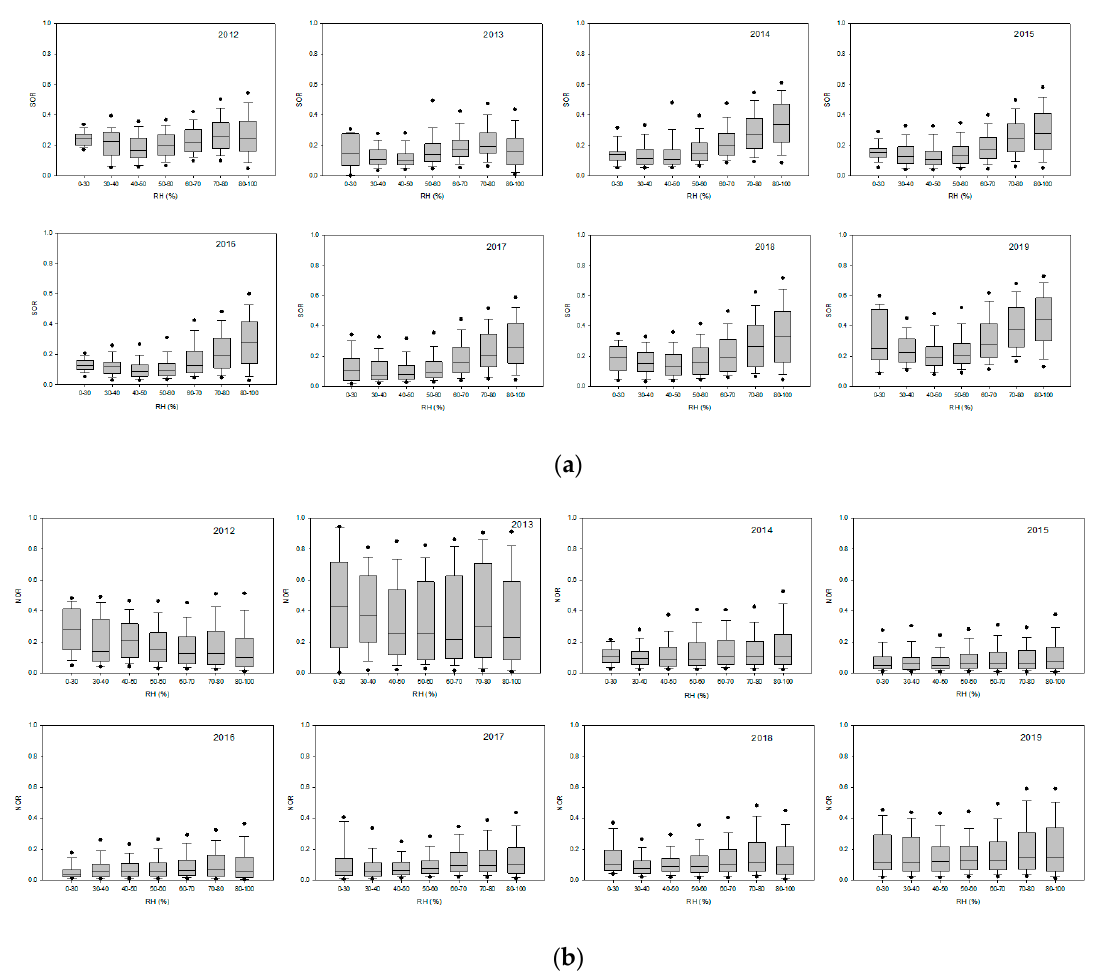
Figure 12. Changes in the SOR and NOR according to RH on Baengnyeong Island: ( a ) SOR; ( b ) NOR.